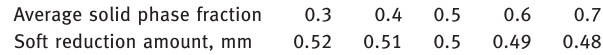
Table 3: Soft reduction amount in different reduction subzone. Average solid phase fraction